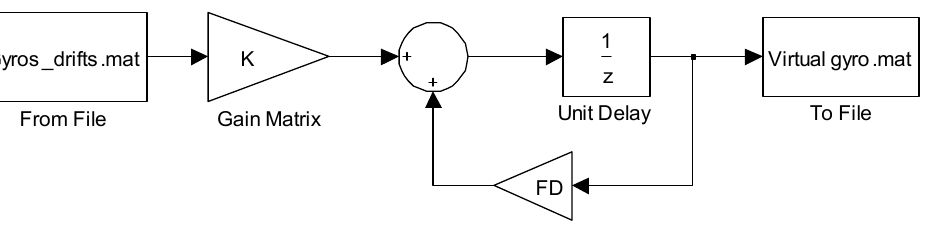
Figure 2. Simulink filtering model for discrete-time